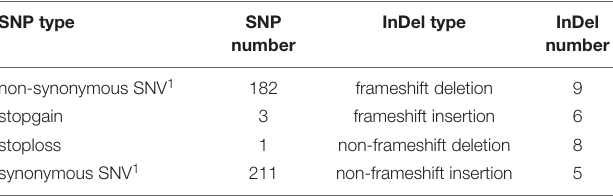
TABLE 4 | The types and numbers of SNPs and InDels in the target QTL region associated with powdery mildew resistance between the melon parental lines wm-6 and